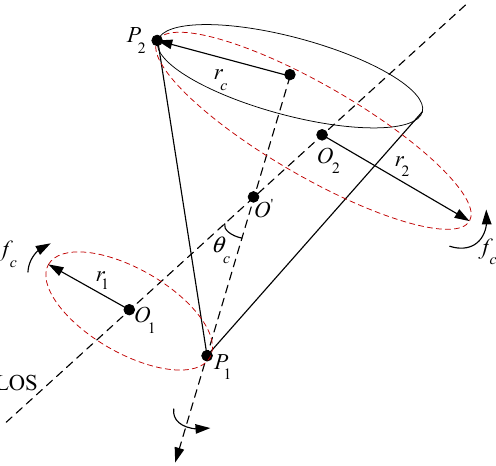
Figure 2. The geometric relationship of the precession cone-shaped target.